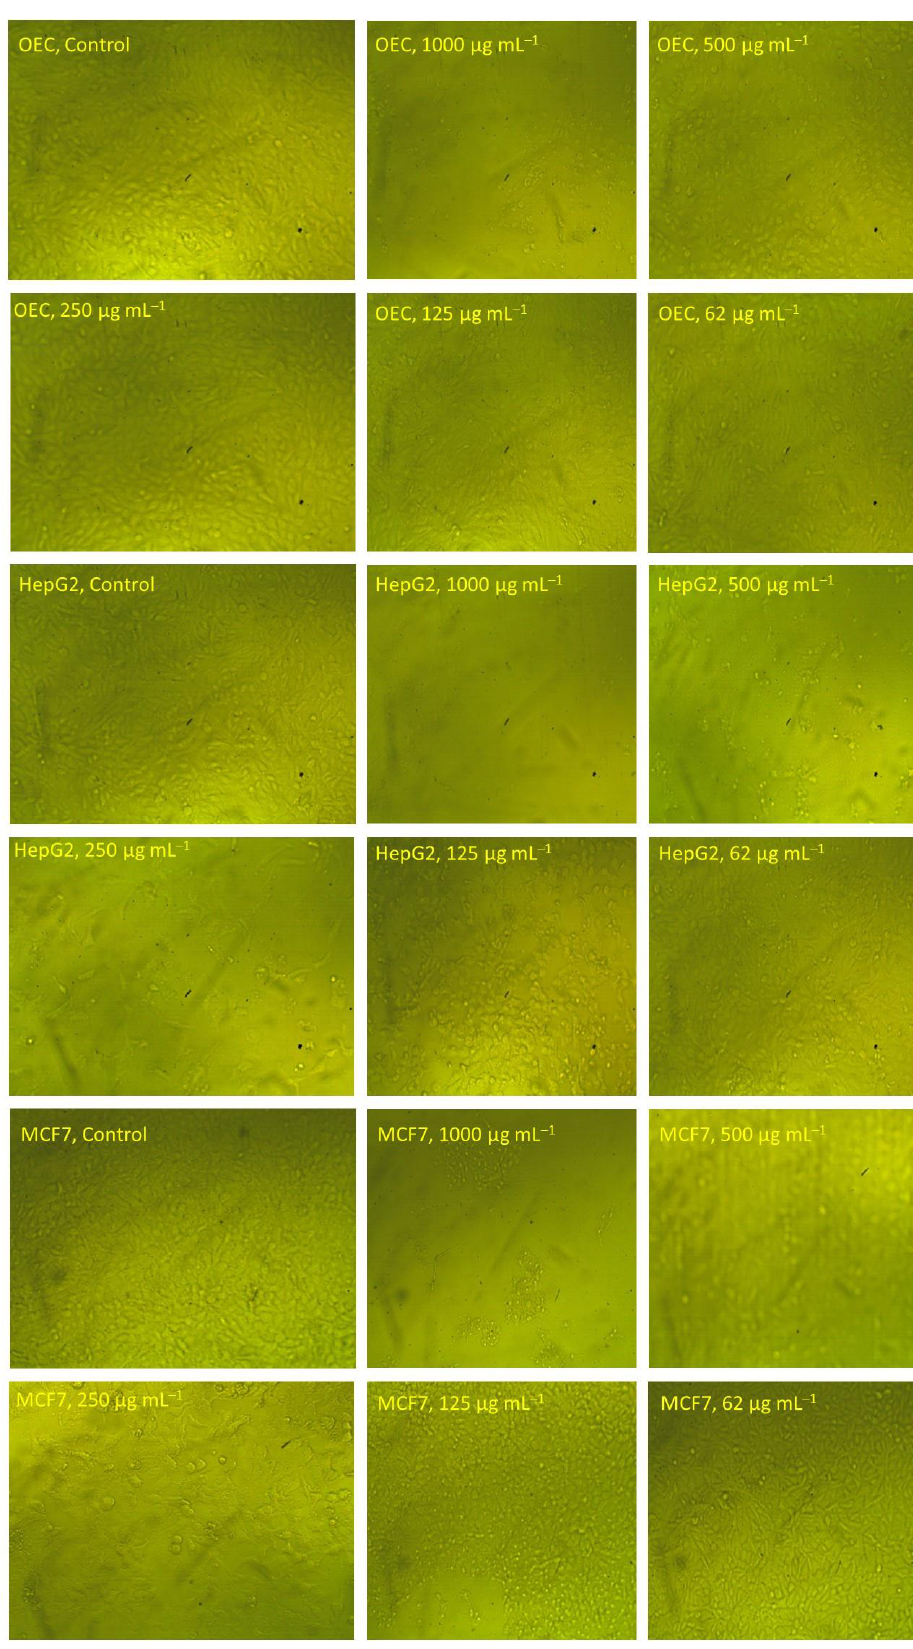
Figure 8. Morphological changes of normal cell lines (OEC) and cancer cell lines (HepG2 and MCF7) after treatment with various concentrations of phytosynthesized AuNPs.